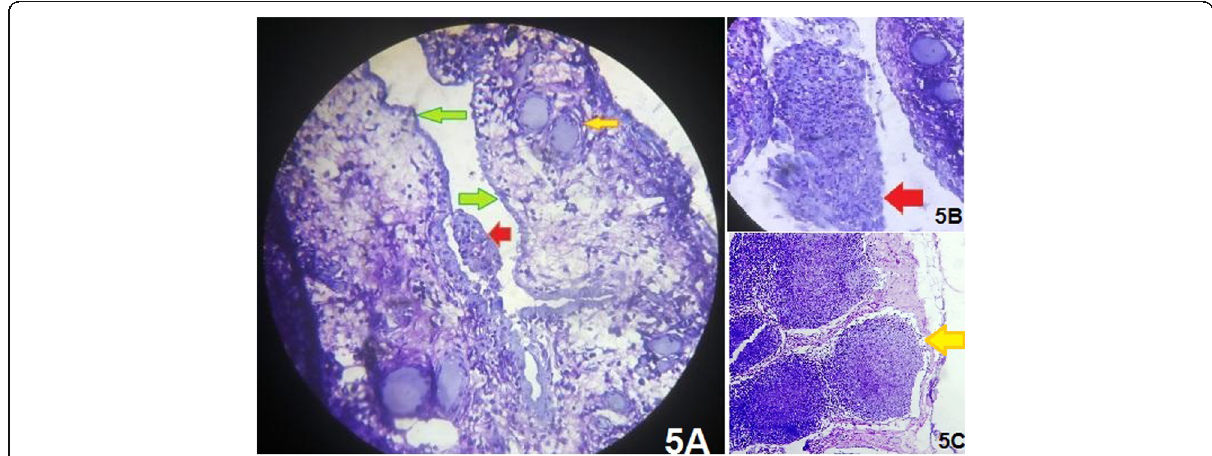
Fig. 5 a Sections from the sac revealed fibro-fatty-collagenous tissue with mixed inflammatory cells. There were dilated lymphatics (yellow arrow) along with a flattened mesothelial lining cell layer (green arrows) suggestive of an infected peritoneal sac (femorocele). Red arrow shows mesothelial tissues (enlarged image in b ) c Sections from the inguinal lymph node showed features of reactive hyperplasia (yellow